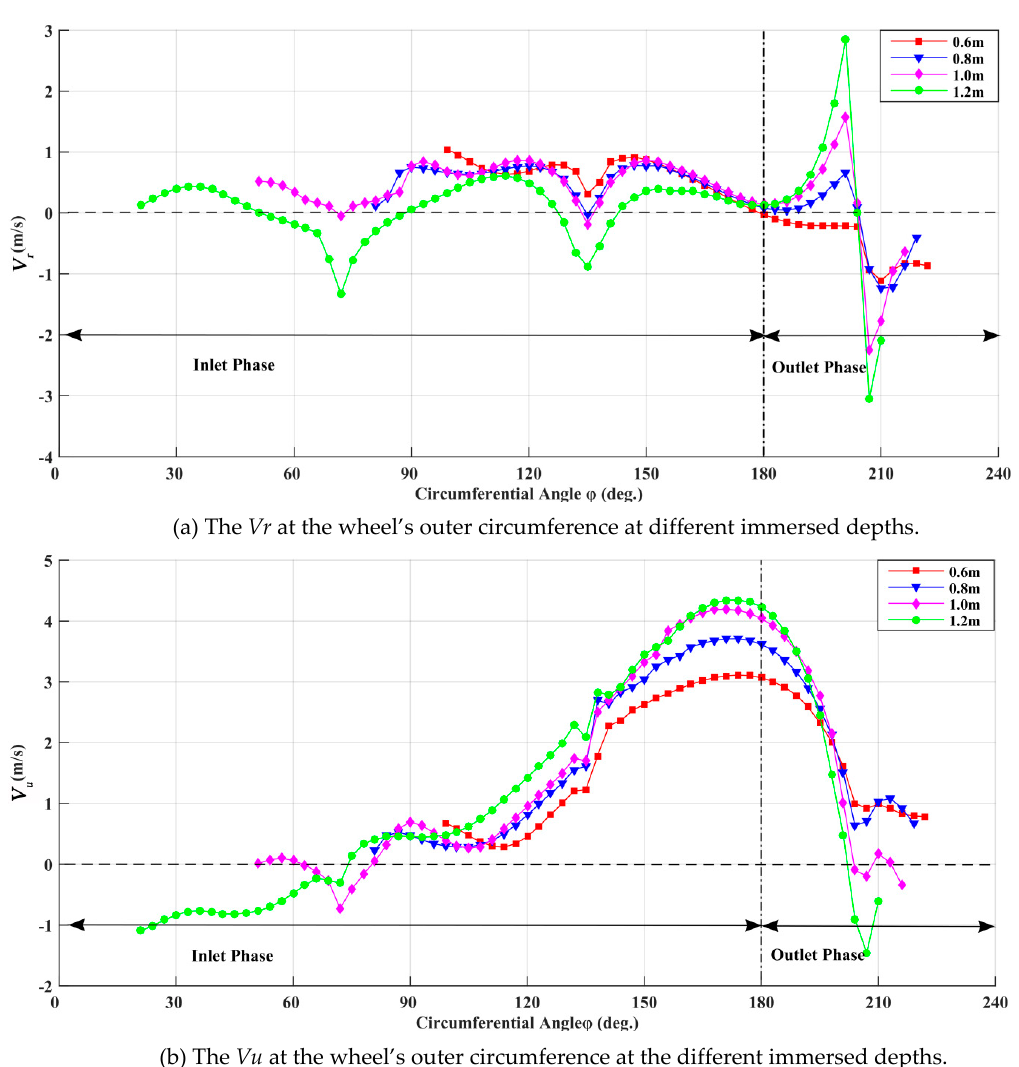
Figure 11. Comparison of Vr and Vu at the wheel’s outer circumference.